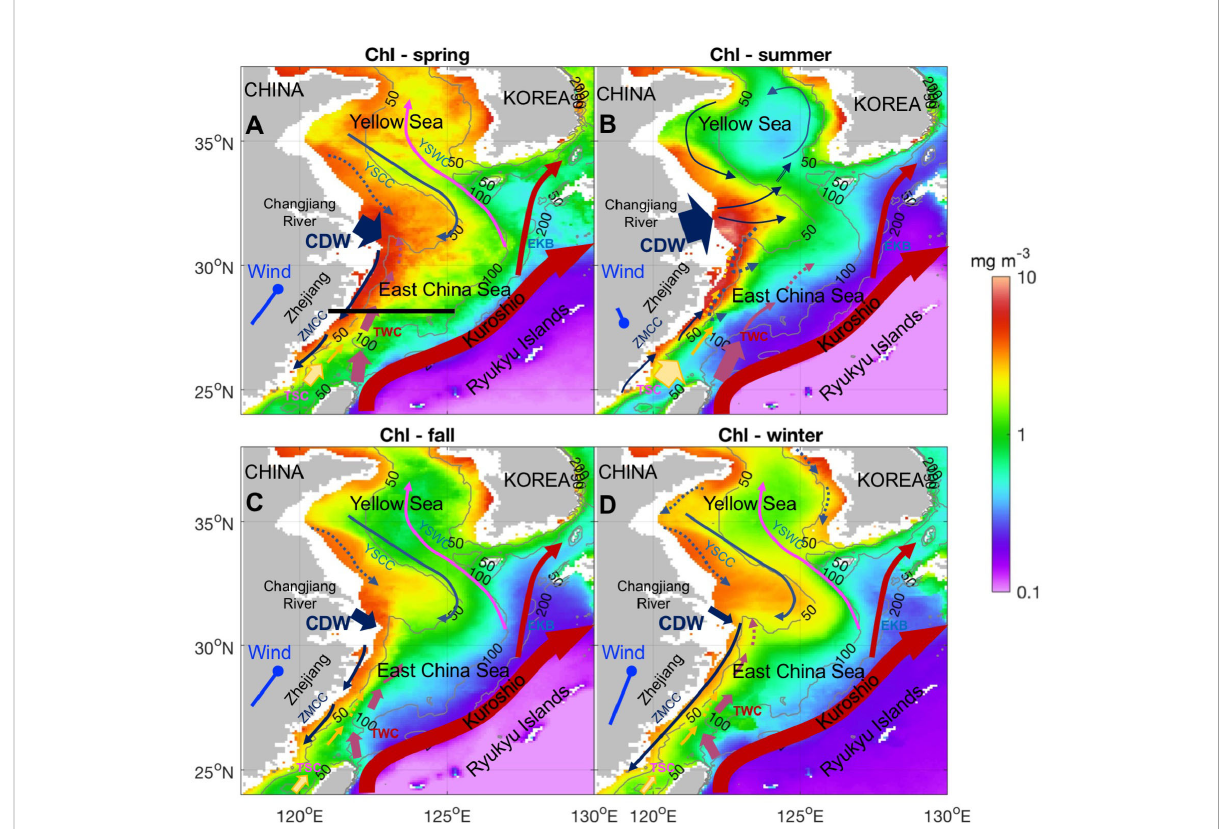
FIGURE 1 Satellite Chl -a seasonal climatology with sketched circulations. (A) Spring (March – May), (B) summer (June – August), (C) fall (September – November), and (D) winter (December – February). [CDW, Changjiang (Yangtze) River Diluted Water; YSCC, Yellow Sea Coastal Current; YSWC, Yellow Sea Warm Current; EKB, Eastern Kuroshio Branch; TWC, Taiwan Warm Current; ZMCC, Zhe-Min Coastal Current]. The winds illustrated are the ERA-Interim climatology of wind vectors in the 25° – 30°N, 120° – 127°E box, which represents the East China Sea. The gray contour lines denote the 50-, 100-, and 200-m